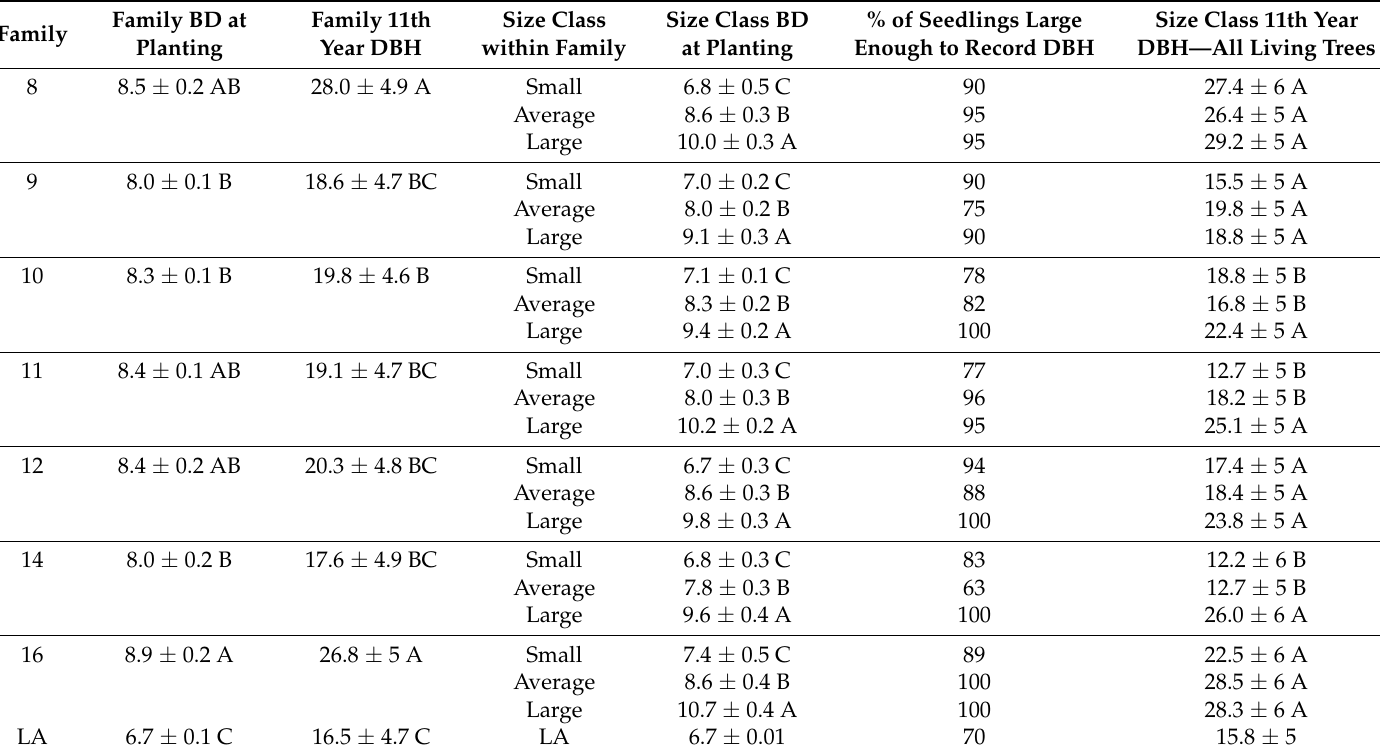
Table 2. Basal diameter (BD, mm) at planting, diameter at breast height (DBH, mm) after eleven years—with trees too short to record DBH (1.27 m) given a DBH of 0 mm—for family and for seedling size class within family. LA indicates locally available seedlings. Means among families for family treatment and within family for size class (family) treatment with the same letters do not differ statistically ( α =